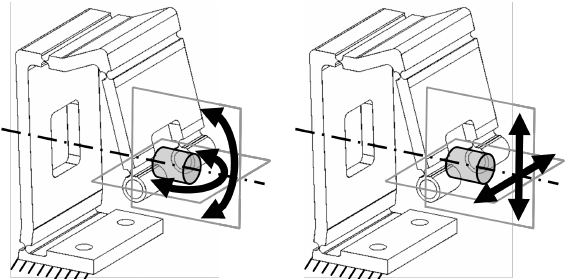
Figure 4. Monolithic frictionless anti-rotation system of the self-sensing linear actuator: canceling of the effects caused by the angular oscillations and the hyper-static